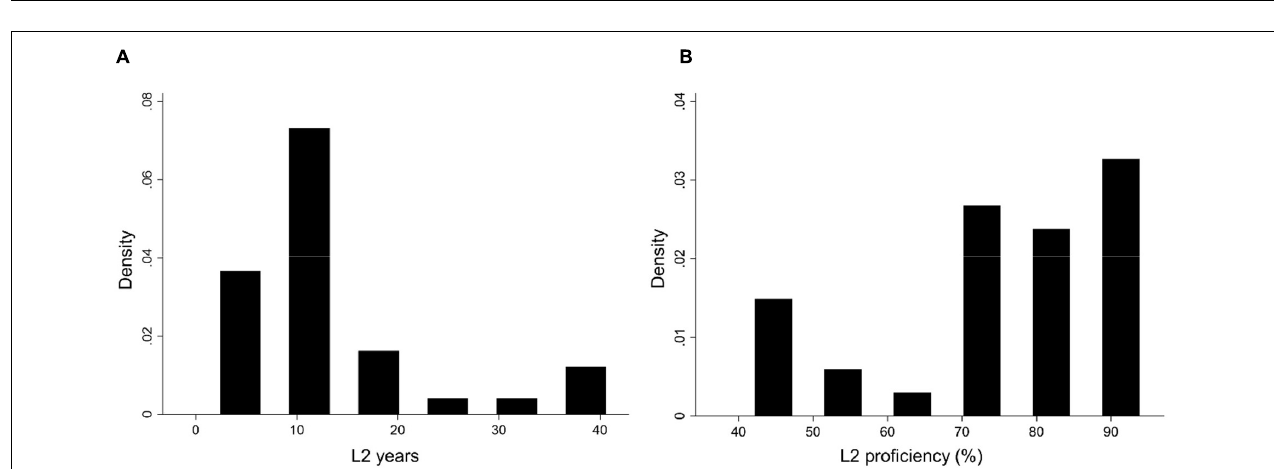
FIGURE 1 | Structure of the structural equation model (SEM) used to derive the CR Proxies latent variable.